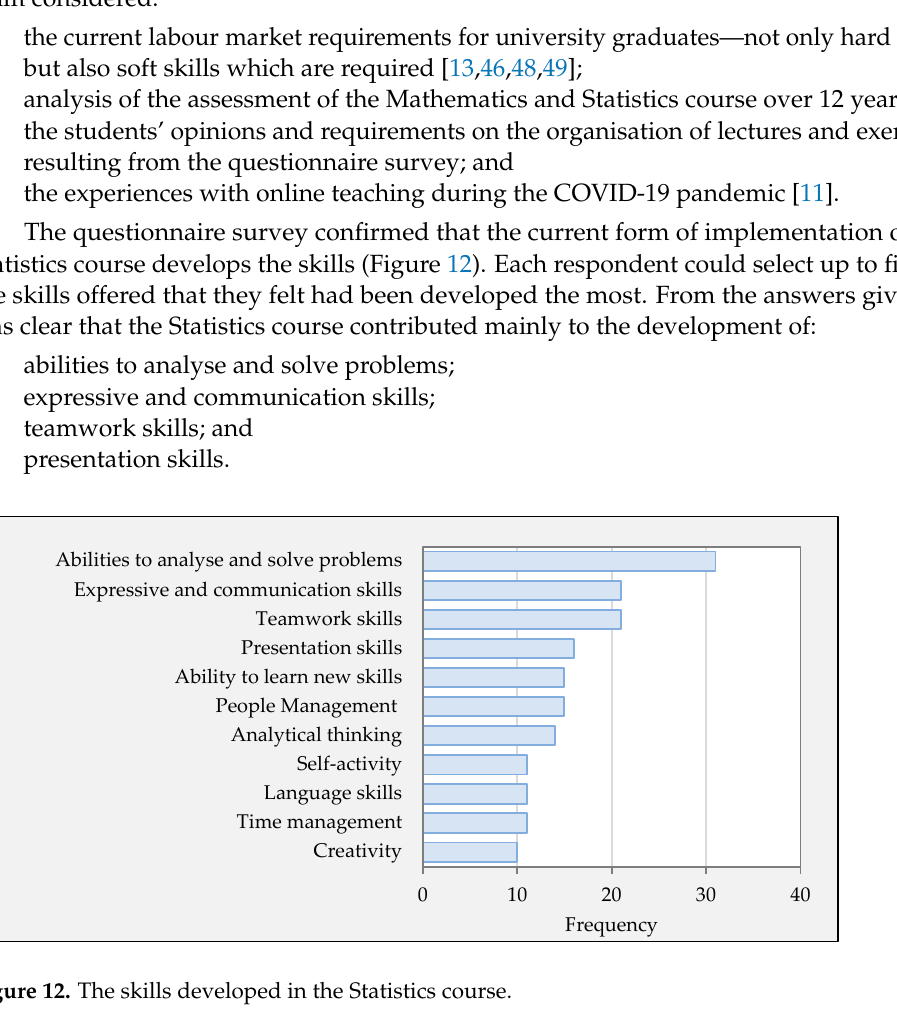
Figure 13. The students’ evaluation of completed lectures . Most of the students (89.16%) would welcome short summary videos to reinforce the learning after the lecture (Figure 14). They could review the important parts of the new topic, the methods covered, and the appropriate tests needed to develop the practical ex- amples solved in the tutorials and the semester projects.